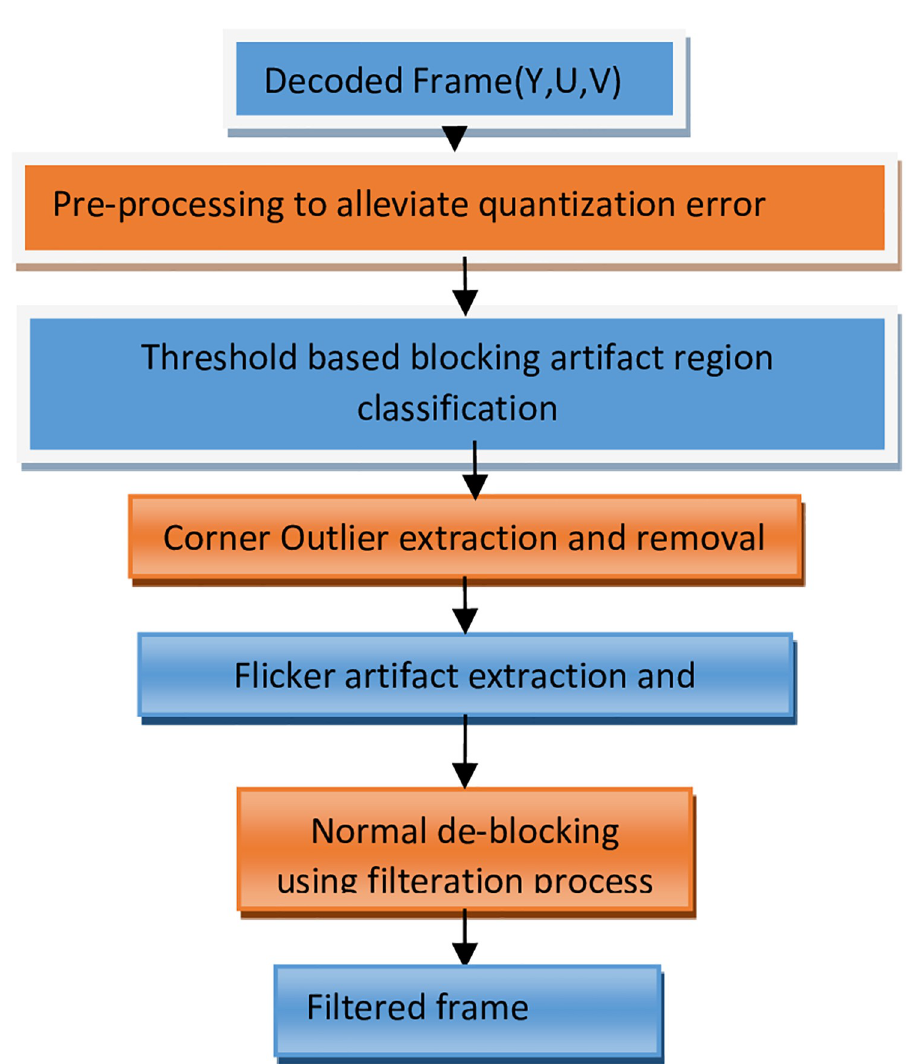
Fig 1. Flow chart of the PP-AFT